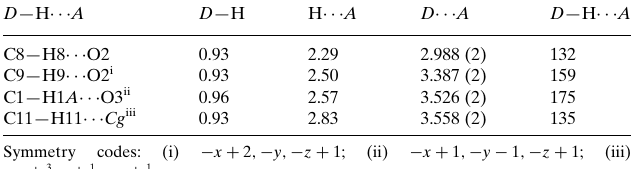
Hydrogen-bond geometry (A˚ , (cid:2)